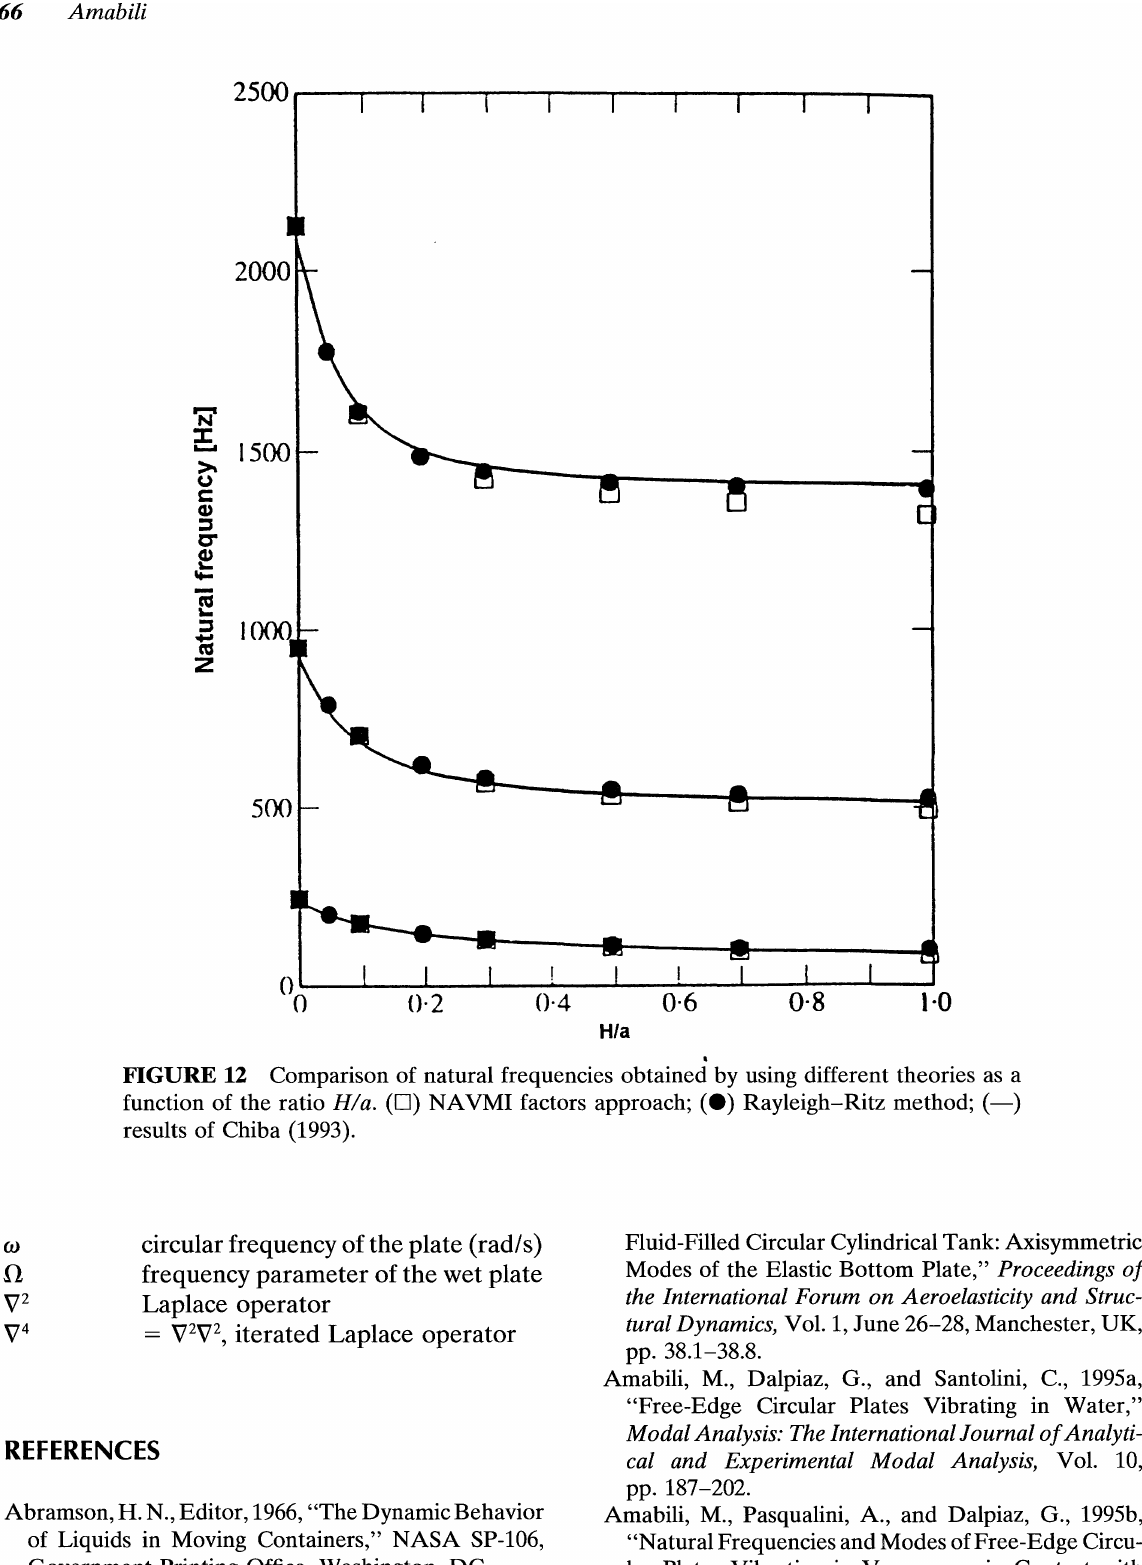
FIGURE 12 Comparison of natural frequencies obtained by using different theories as a function of the ratio H/a. (D) NAVMI factors approach; (e) Rayleigh-Ritz method; (-) results of Chiba